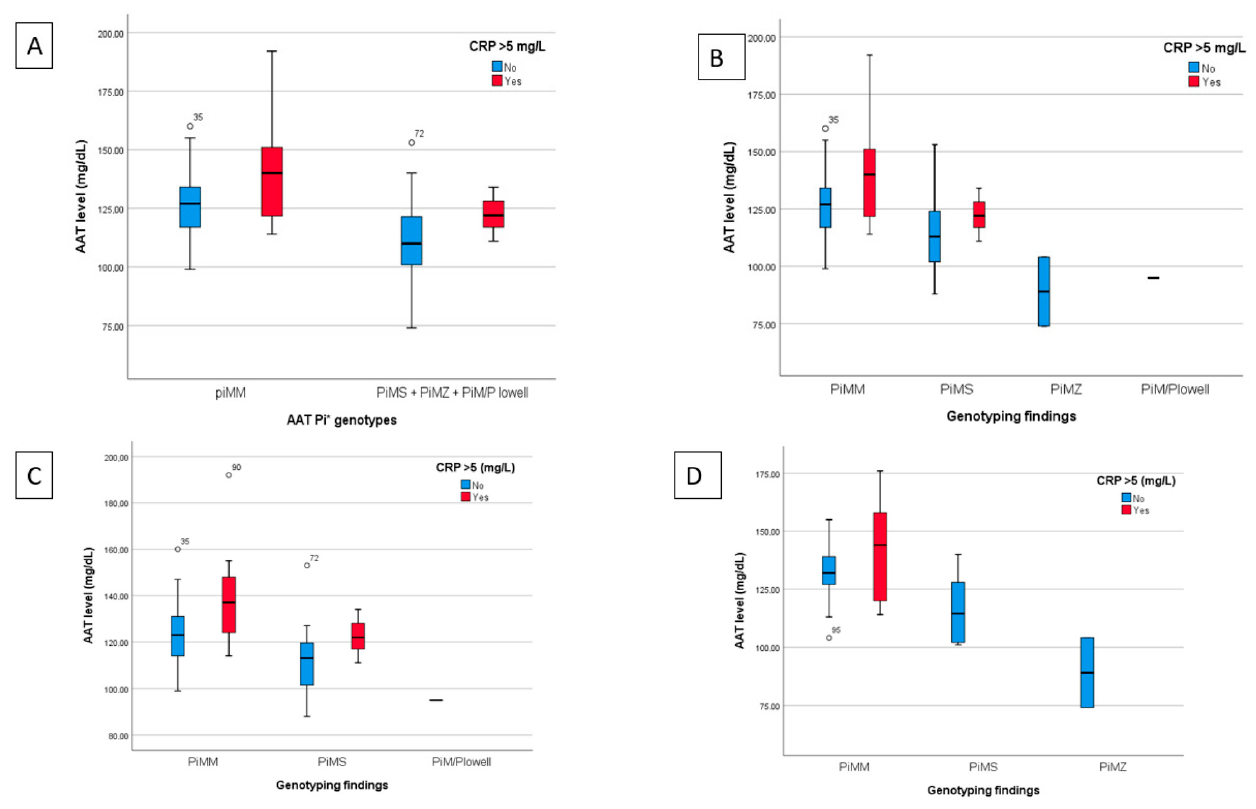
Figure 3. Findings from the plasma determination of AAT, allelic genotype and CRP determination for all hospitalised patients and for the subgroups of patients with normal or impaired lung function at 12 months. ( A ) Breakdown of AAT levels classified by normal genotype (Pi*MM) or unified heterozygous deficiencies (Pi*MS, Pi*MZ and Pi*M/P Lowell) and stratified by normal or elevated CRP for all hospitalised patients. ( B ) Comparison of AAT levels based on genotyping (Pi*MM, Pi*MS, Pi*MZ and Pi*M/P Lowell) and the normal or high CRP value for hospitalised patients. C and D) AAT values analyzed based on genotype and normal or elevated CRP of the subgroups of patients with normal ( C ) or impaired lung function ( D ) at the 12 month follow ‐ up.